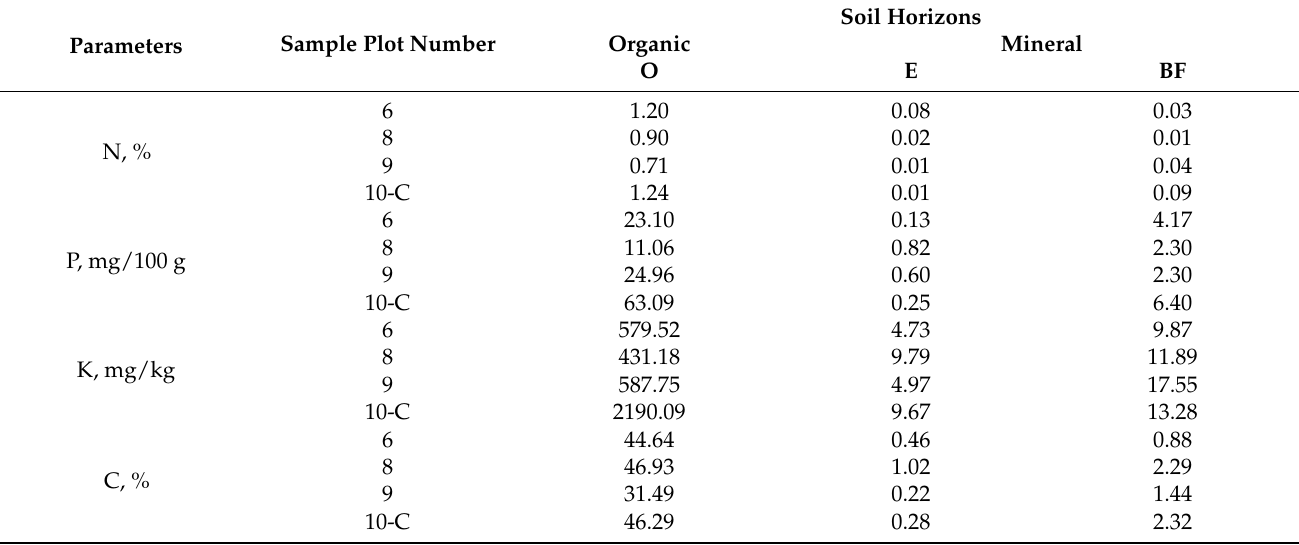
Table 5. Chemical properties of soils 10 years after surface